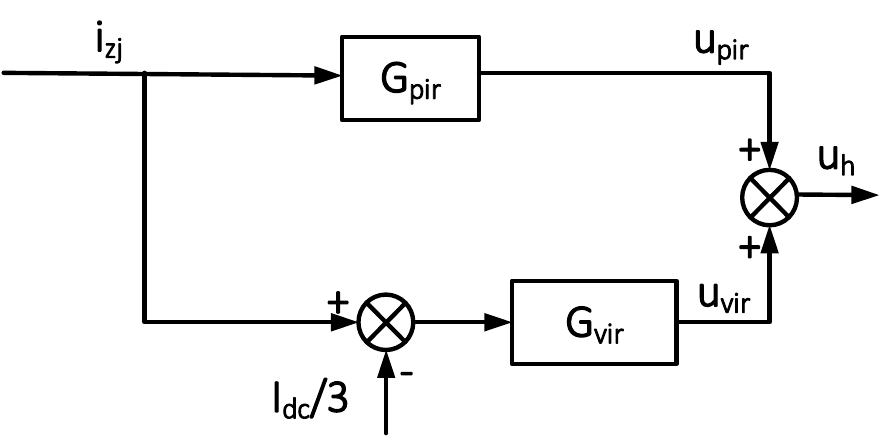
u v Figure 5. Virtual impedance equivalence diagram. In the controller, the virtual impedance link is the first-order inertial link, whose transfer function is: